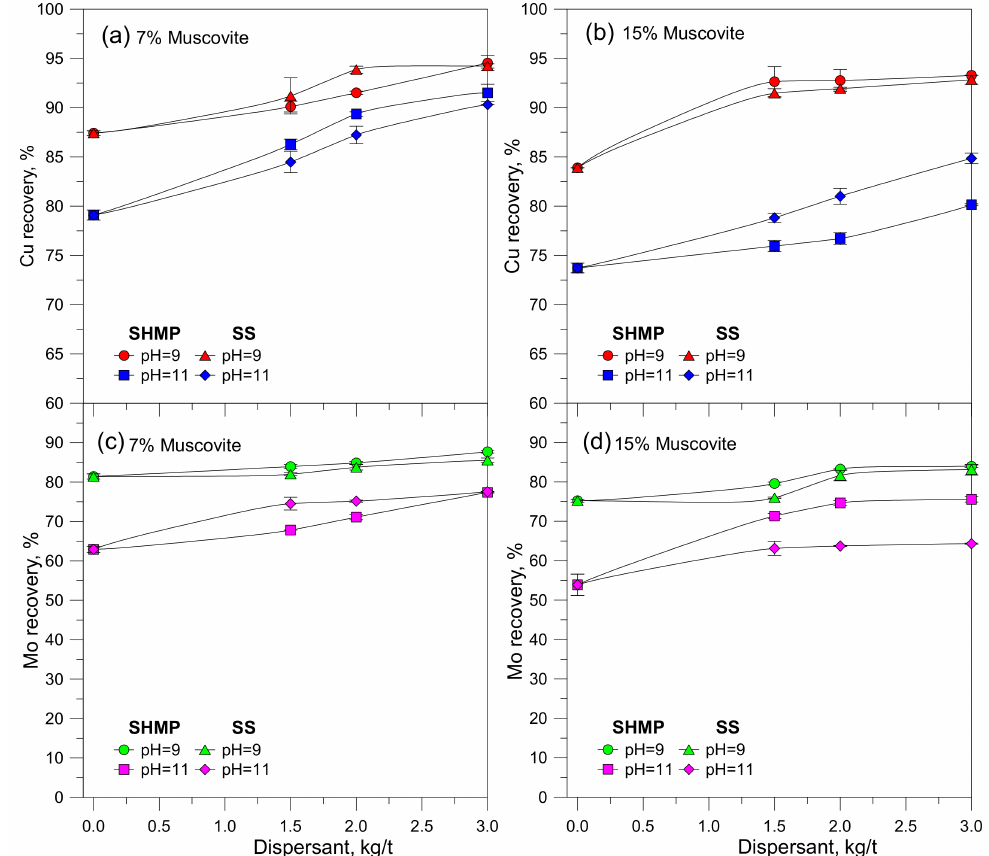
Figure 2. Copper ( a , b ) and molybdenum ( c , d ) recoveries in seawater at pH 9 and 11, as a function of dispersant dosage (SHMP, SS), and two muscovite